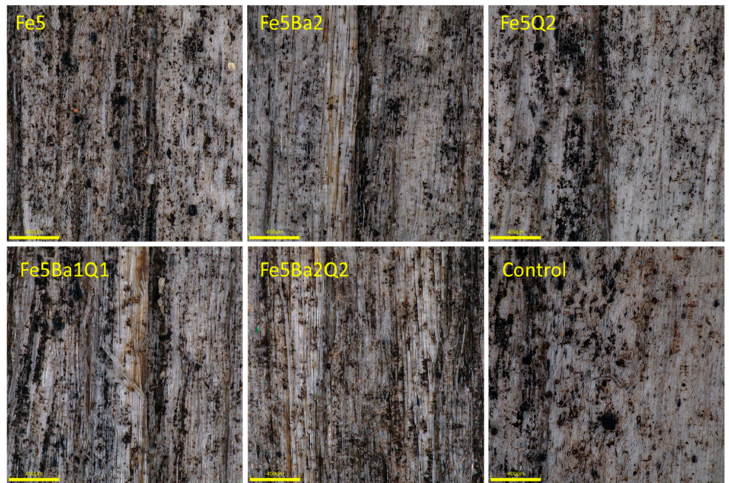
Figure 7. Surface of control and treated Siberian larch samples after 172 weeks of outdoor exposure.